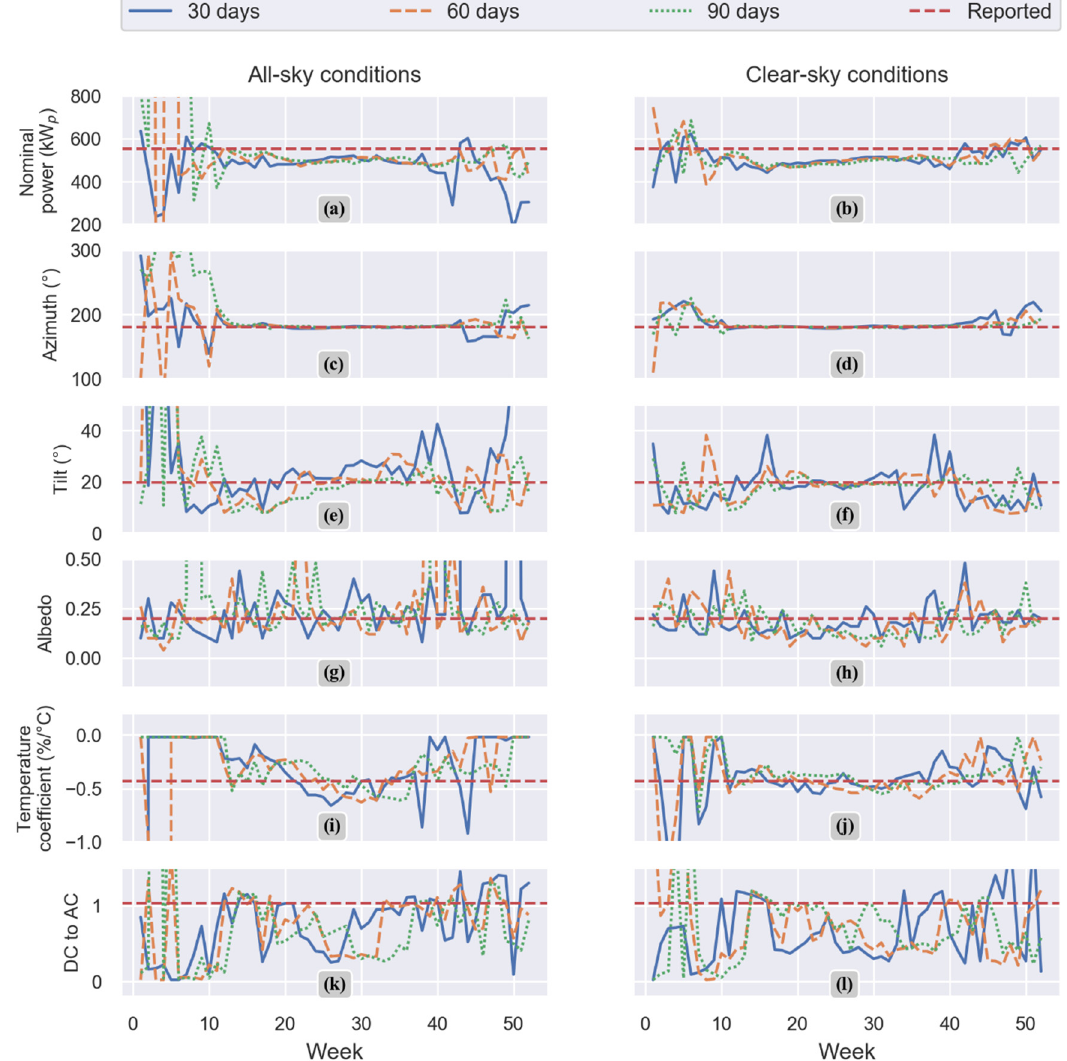
Figure 7. Parametrization results of the GA optimization. Left hand side subfigures ( a , c , e , g , i , k ) show the parametrization results considering all-sky conditions as training data and right hand side subfigures ( b , d , f , h , j , l ) show the parametrization results considering only clear-sky conditions as training data.